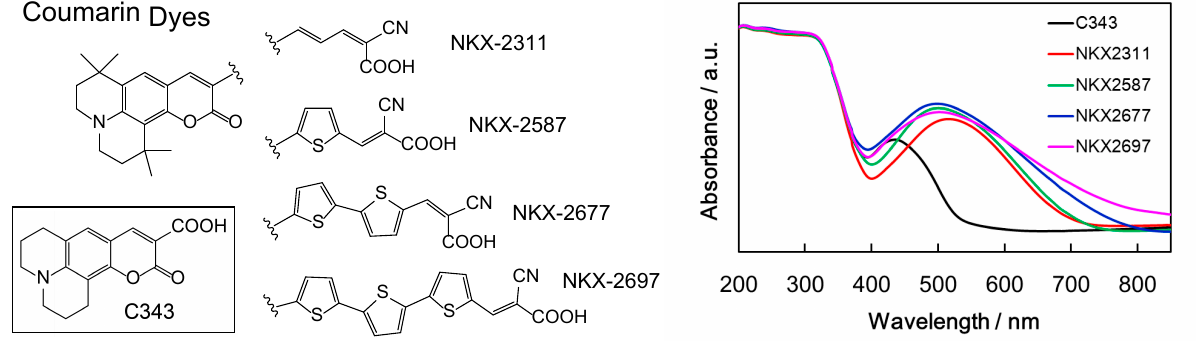
Figure 2. Coumarin dyes and diffuse reflectance spectra of coumarin-TiO 2